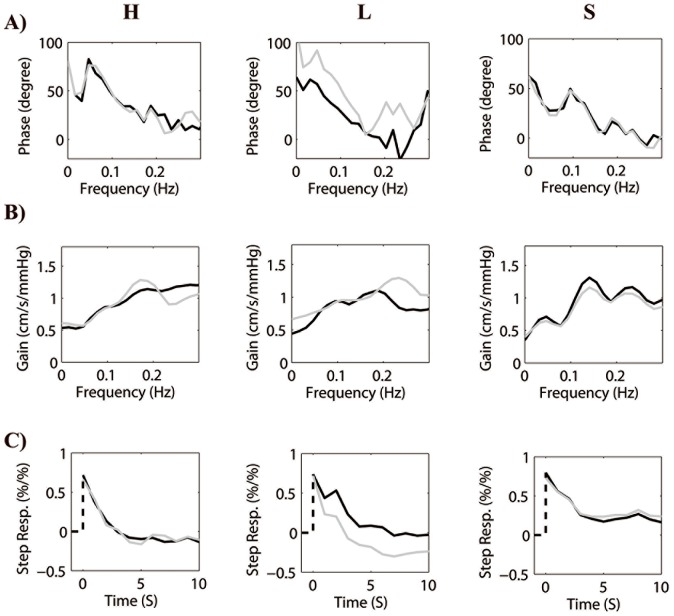
Three autoregulatory parameters, A) phase difference, B) gain, and C) step response, derived from the transfer function are plotted.H (: right side and : left side), L (: affected side and : unaffected side), and S (same legends as L) denote healthy controls, large-artery atherosclerosis group, and small-artery occlusion group, respectively. The first column shows that all parameters in the healthy group from both sides indicate that autoregulation is intact. There is evident positive phase difference. The shape of high-pass filter can also be speculated. The step response, H-C), shows that cerebral blood flow velocity quickly returns to the baseline level within approximately 4 seconds if a unit step change of arterial blood pressure is induced. In the second column, the parameters changes asymmetrically. Dynamic cerebral autoregulation on the affected side is substantially reduced than the unaffected side with decreased phase difference, flattened gain, and slower return of cerebral blood flow velocity in response to a step change of arterial blood pressure. In the last column, this series of subplots show that autoregulation is worsen bilaterally when comparing with the healthy controls.